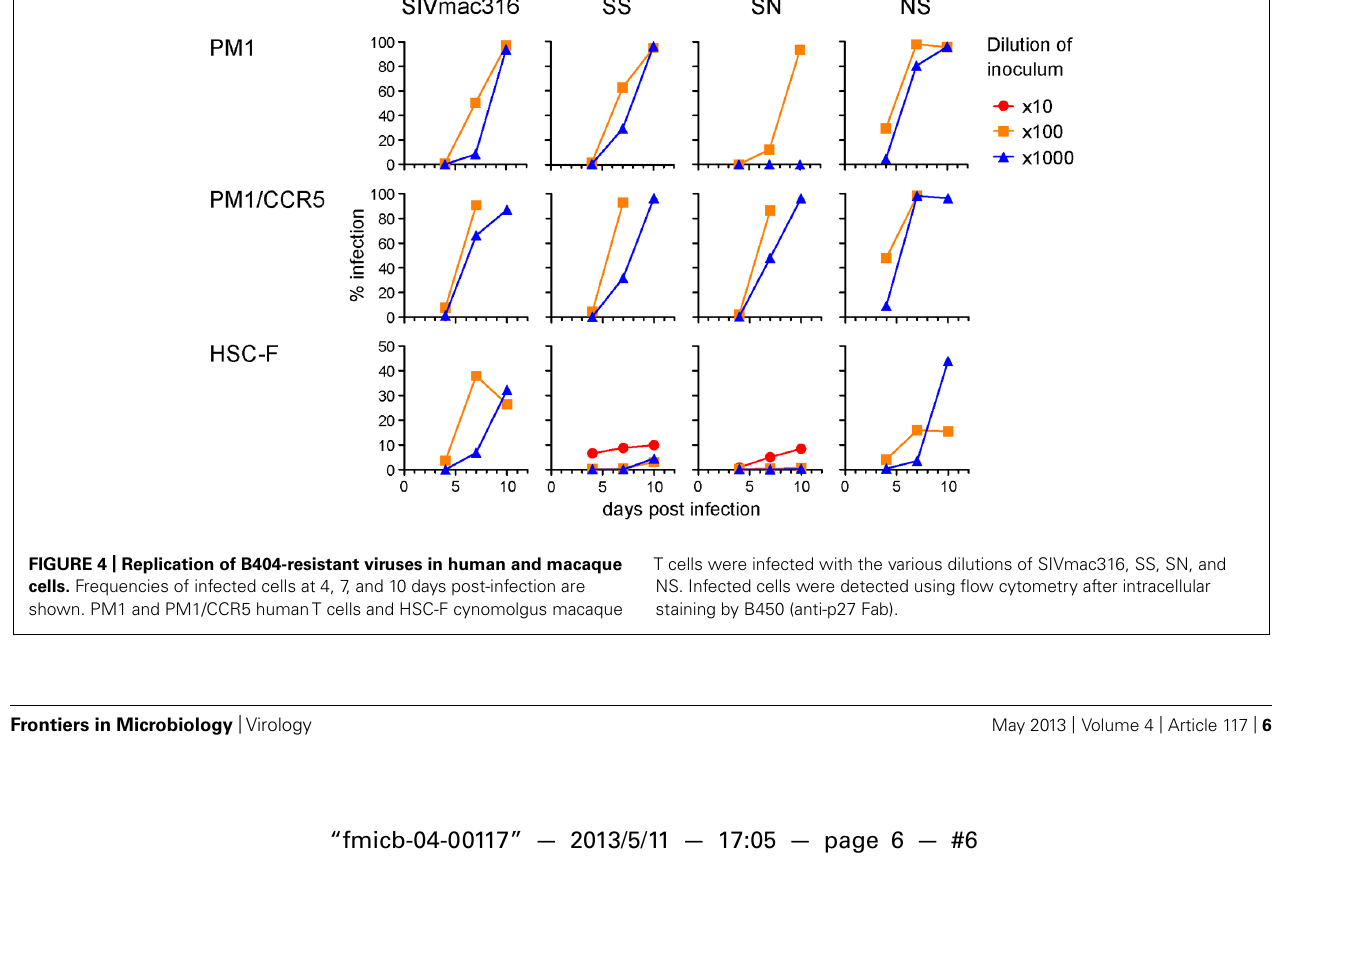
FIGURE 4 | Replication of B404-resistant viruses in human and macaque cells. Frequencies of infected cells at 4, 7, and 10 days post-infection are shown. PM1 and PM1/CCR5 humanT cells and HSC-F cynomolgus macaque